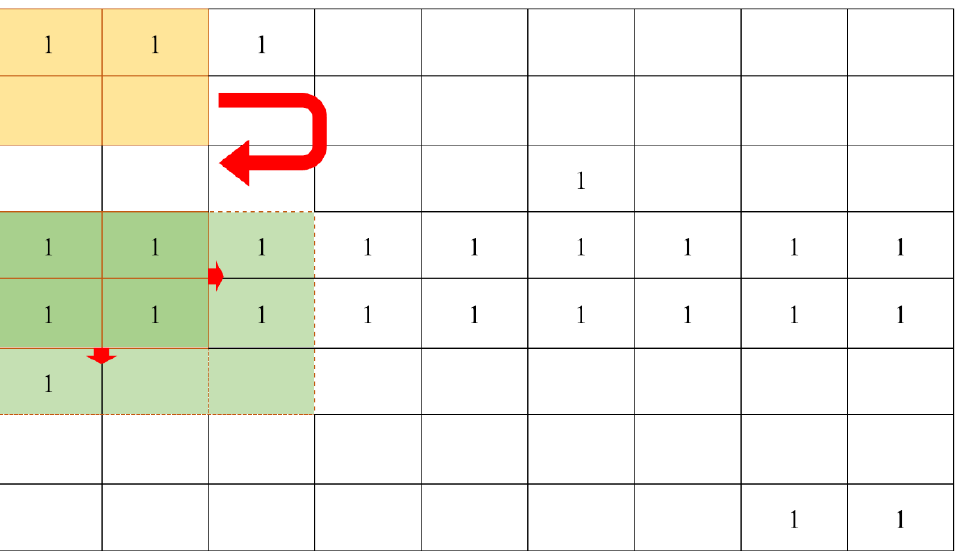
Algorithm 2: Pseudo-code of Adaptive Window Algorithm of Light Stripe Center Extraction Input: I 3 : light intensity equalization image of light stripe